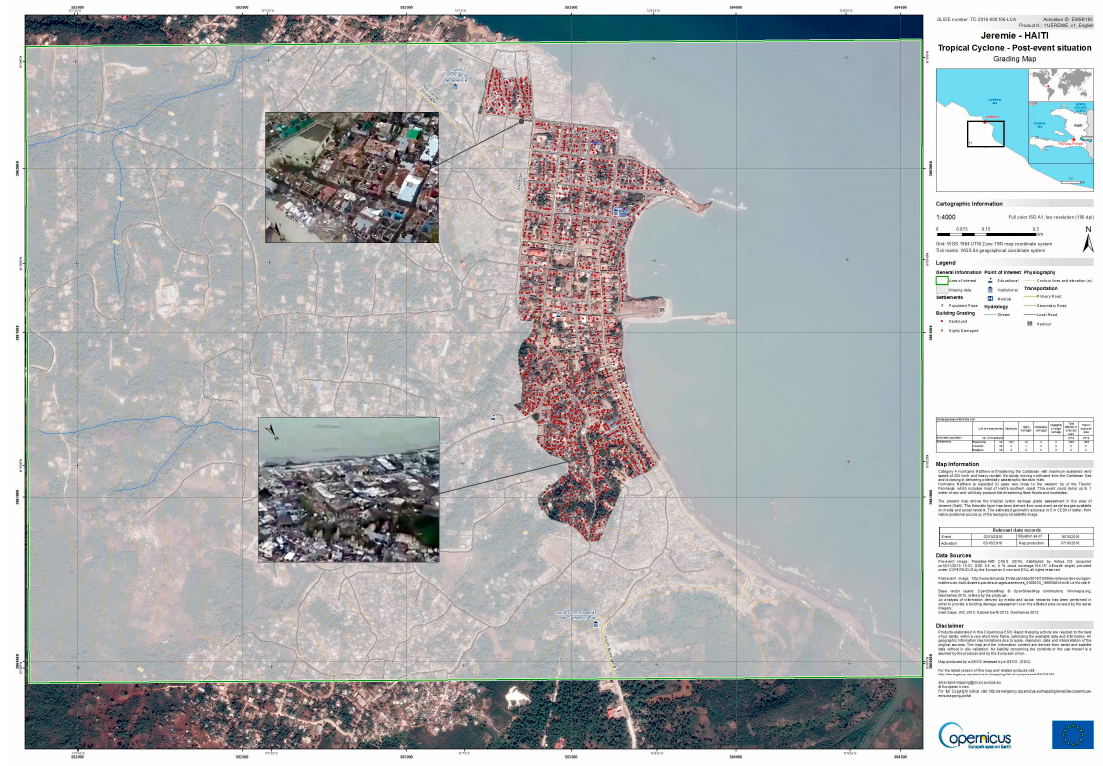
Figure 8. Grading map produced over Jérémie (Haiti) based on the visual interpretation of a video recorded from a helicopter distribute by Le Monde [110], Copernicus Emergency Management Service (© 2016 European Union), EMSR185.